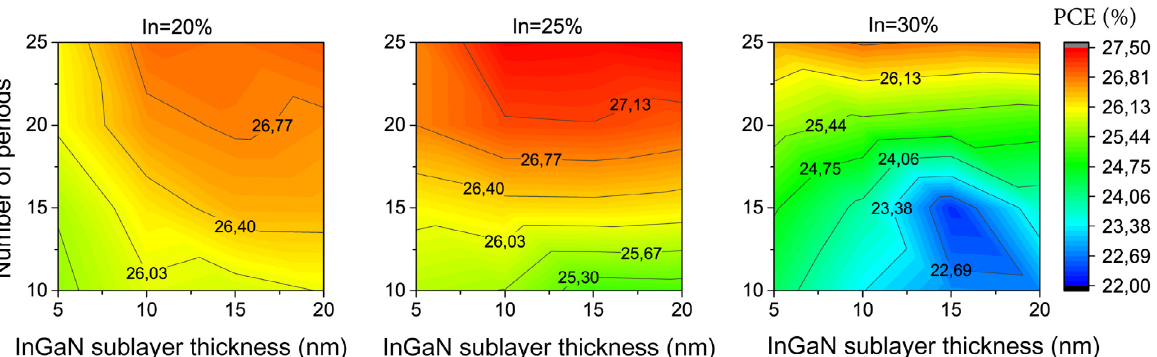
Fig. 6. PCE of InGaN/Si 4-terminal tandem cell as a function of InGaN sublayers’ thickness and number of periods. The indium composition has been varied for 20%, 25% and 30%.